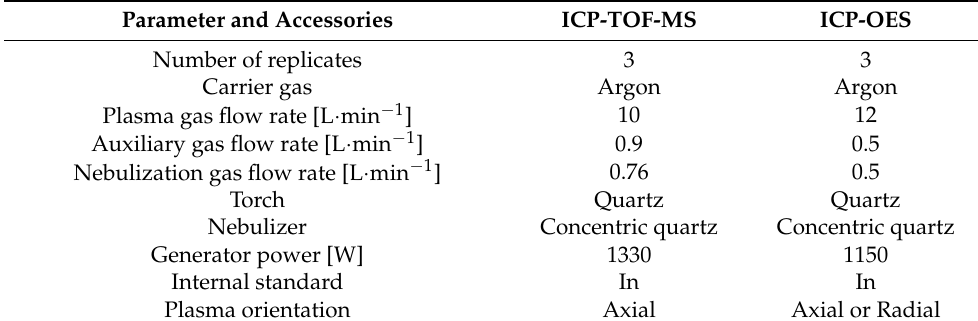
Table 4. ICP-ToF-MS (OptiMass 8000, by GBC Melbourne, Australia,) and ICP-OES (Thermo Scientific, ICAP 7000 series, MA, USA) parameters and measurement